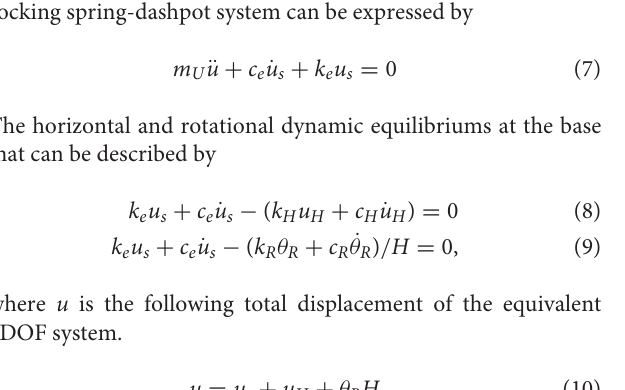
The equation of motion of the SDOF system on a